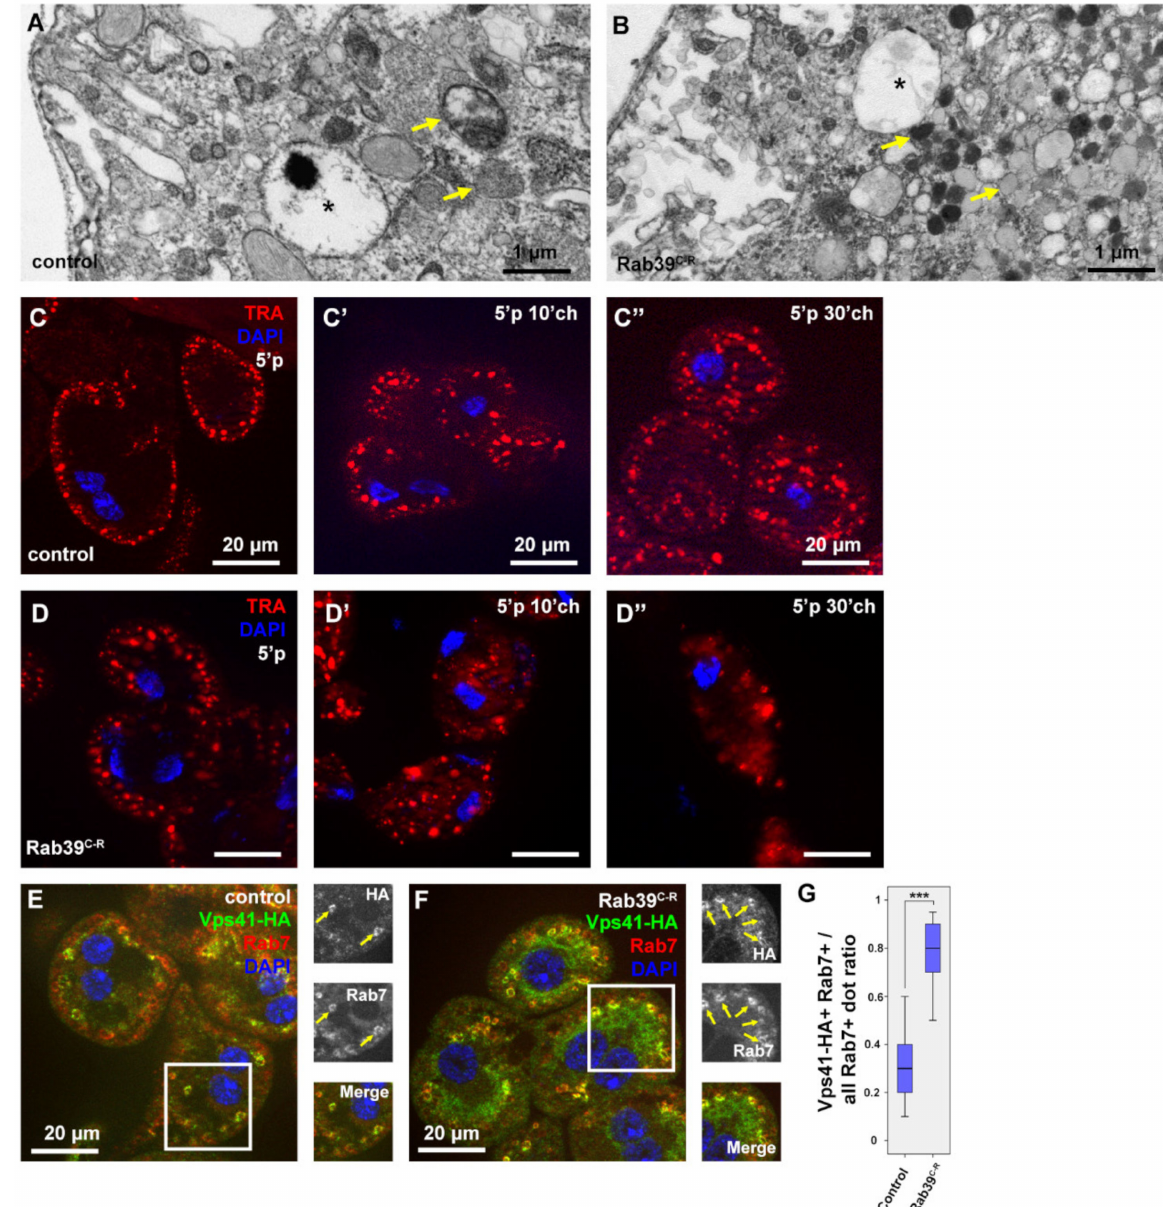
Figure 3. Endocytosis is accelerated in Rab39 depleted nephrocytes of L3 stage wandering larvae. ( A , B ) An ultrastructural analysis revealed normal late endosomal (marked with asterisks) size and distribution both in control ( A ) and Rab39 mutant ( B ) nephrocytes. In the mutant cells, however, only small, electron-dense lysosomes were present as opposed to control cells where lysosomes were larger. Two representative lysosomes are marked with arrows in both cases. ( C , D ) TRA was taken up by control ( C ) or Rab39 mutant ( D ) nephrocytes for 5 min, and it was chased 0 ( C , D ), 10 ( C ’, D ’) or 30 min ( C ”, D ”). In the mutant cells, TRA was internalized and degraded faster than in control cells. ( E , F ) The HA-tagged HOPS-subunit Vps41/Lt and late endosomal Rab7 were co-stained to detect their colocalization in control ( E ) and mutant cells ( F ). The colocalization increased upon Rab39 mutation. Boxed regions are enlarged in insets in ( E , F ) and colocalizing signals are marked with arrows. ( G ) Quantification of the experiments depicted in ( E , F ), n = 10 cells. None of the samples showed Gaussian distribution. Medians are shown as horizontal black lines within the boxes. Bars show the upper and lower quartiles, and the whiskers plot the smallest and largest observations. ***: p < 0.001. Heterozygous Rab39 C-R animals with ( E , G ) or without ( A , C ) the indicated transgenes were used as